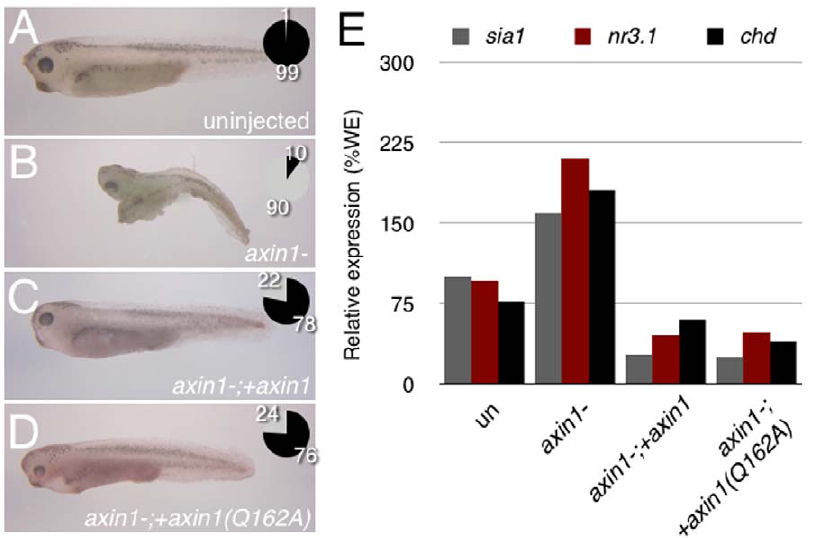
Figure 4. Both axin1 and axin1(Q162A) rescue hyperdorsalization in maternal axin1 -depleted embryos. ( A–D ) Representative phenotypes of control and axin1 -depleted Xenopus embryos obtained following host transfer. Chart showing distribution of phenotypes is inset in each panel, percentages are indicated; black=normal, grey=dorsalized. ( A ) control uninjected stage 37 embryo, (n=40) ( B ) axin1 -depleted embryo (4 ng oligo; n=44), ( C ) axin1 -depleted embryo injected with 60 pg axin1 mRNA (n=32), ( D ) axin1 -depleted embryo injected with 60 pg axin1(Q162A) mRNA (n=21). ( E ) Representative realtime RT-PCR of sia1 , nr3.1 and chd expression in control whole embryos (un), axin1- depleted embryos ( axin- ) and axin- embryos injected with axin